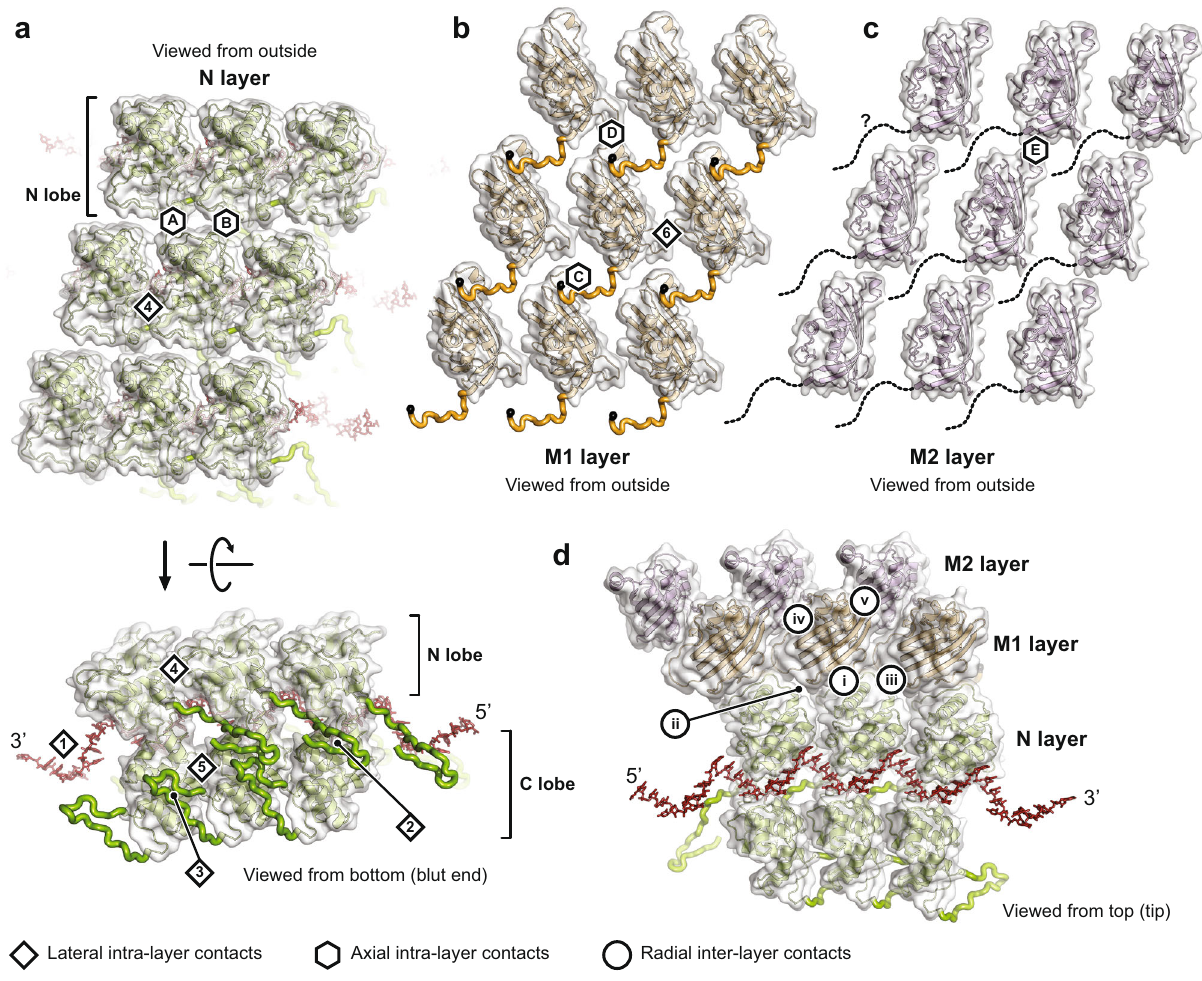
Fig. 4| Inter-subunit contacts. RNAisshowninred stickrepresentation.Globular domains are shown with transparent surface, extensions as thick ribbon. Lateral intra-layer contacts are labeled with diamonds and Arabic numerals, axial intra- layercontactswithhexagonsandletters,andradialinter-layercontactswithcircles andRomannumerals.SeealsoTable1. a Inter-subunitcontactswithintheNprotein